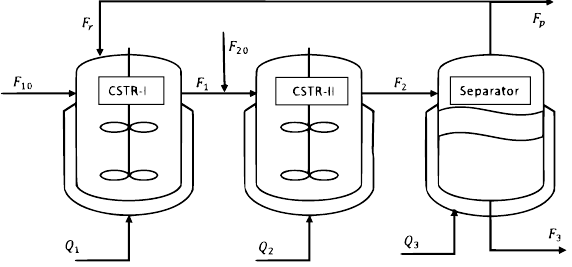
Figure 2. Two continuous-stirred tank reactors and a flash separator